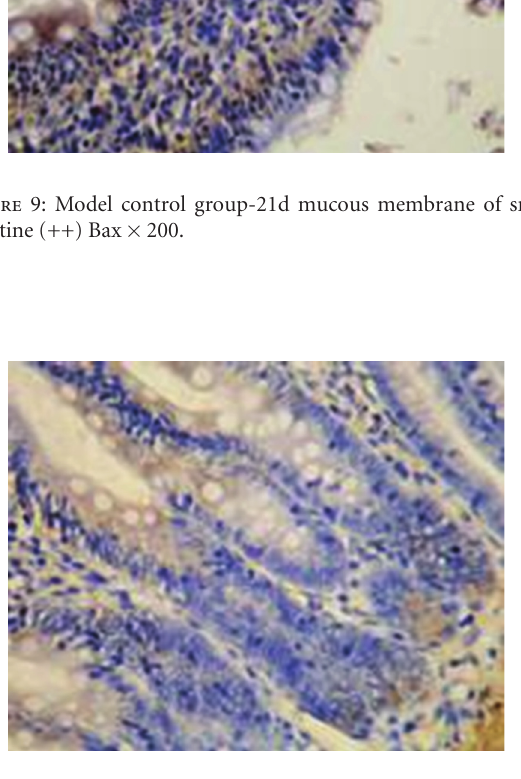
Figure 10: Treated group-21d mucous membrane of small intestine (+) Bax × 200.